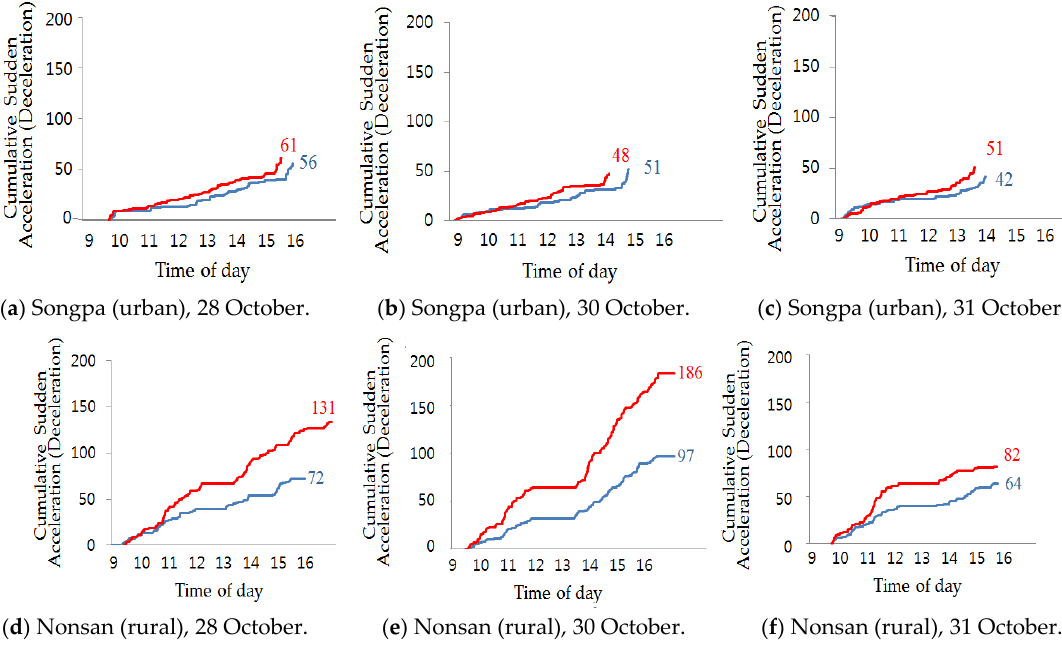
Figure 6. Distribution of cumulative sudden accelerations (blue) and decelerations (red) by time of day, collected by two postal motorcyclists working in Songpa (urban) and Nonsan (rural), respectively.